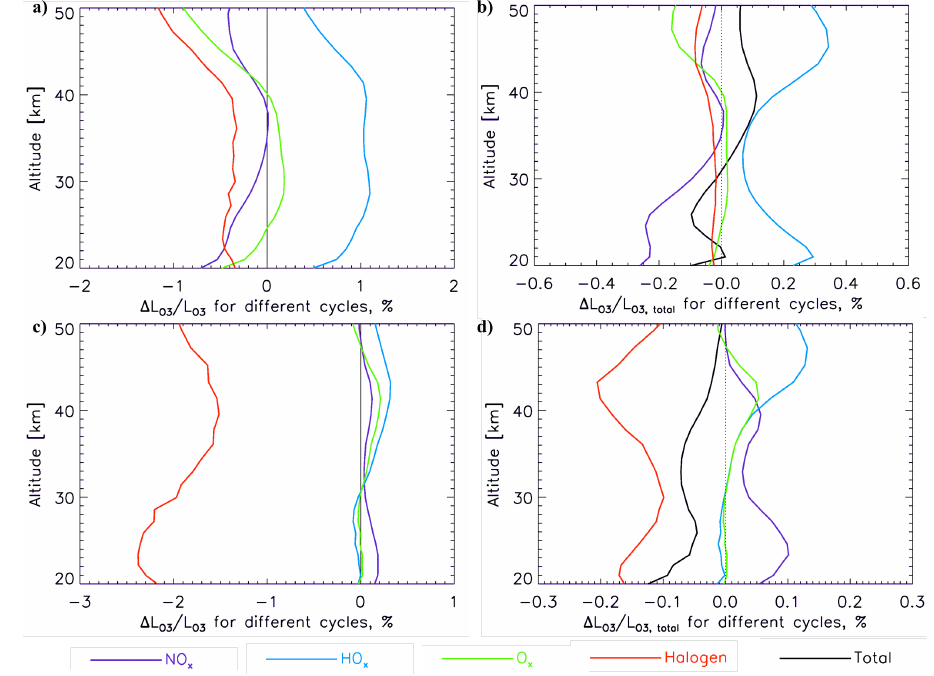
Figure 11. Changes in contributions of different catalytic O 3 destruction cycles to the total O 3 loss in the H 2 -ICE scenarios compared to the Baseline scenario. Panels (a) and (b) are for A1FI and panels (c) and (d) are for B1. (a) and (c): % change in contribution of each catalytic cycle compared to its contribution in the BL; (b) and (d): % change in contributions of different catalytic O 3 destruction cycles compared to the total O 3 loss rate in BL. All figures are daily averaged values for the September equinox at 35ºN.